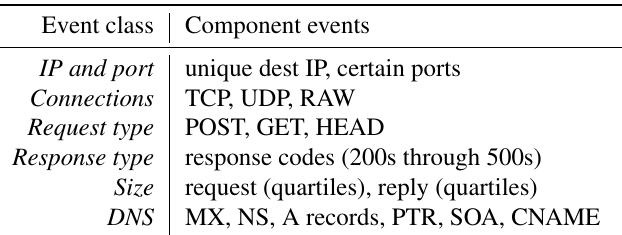
Table 1. Events used in composing the behavioral documents of malware